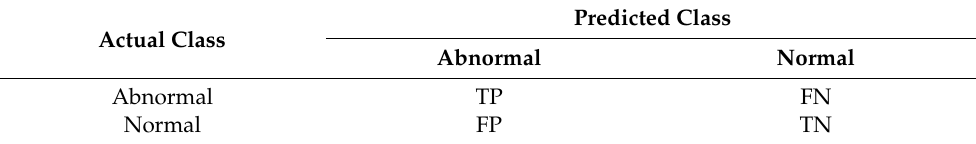
Table 1. Confusion